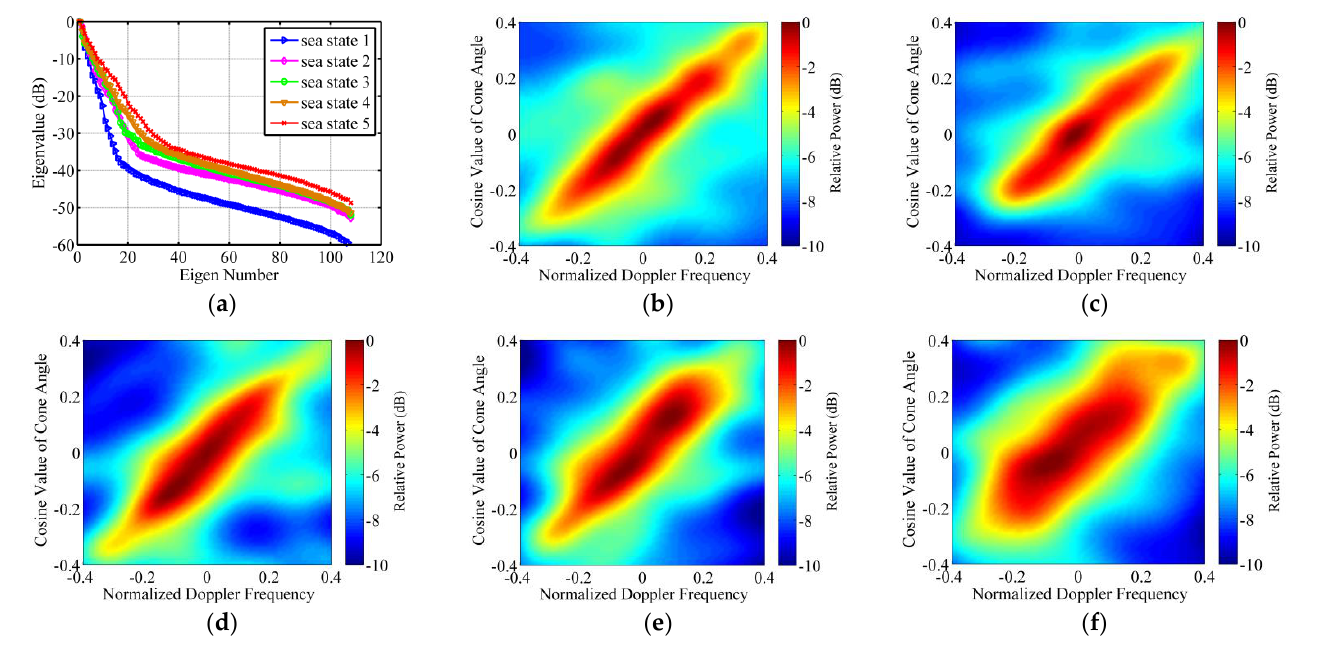
Figure 15. Comparison of the space-time characteristics in different sea states with the same CNR: ( a ) eigenvalue spectrum under 5 sea states; ( b ) power spectrum under sea state 1; ( c ) power spectrum under sea state 2; ( d ) power spectrum under sea state 3; ( e ) power spectrum under sea state 4; and ( f ) power spectrum under sea state 5.